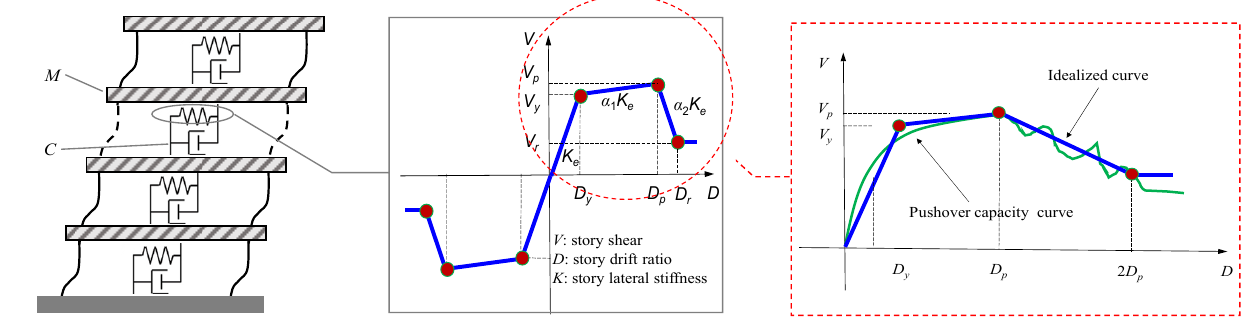
Figure 1. Shear-building model used to derive the design procedure.